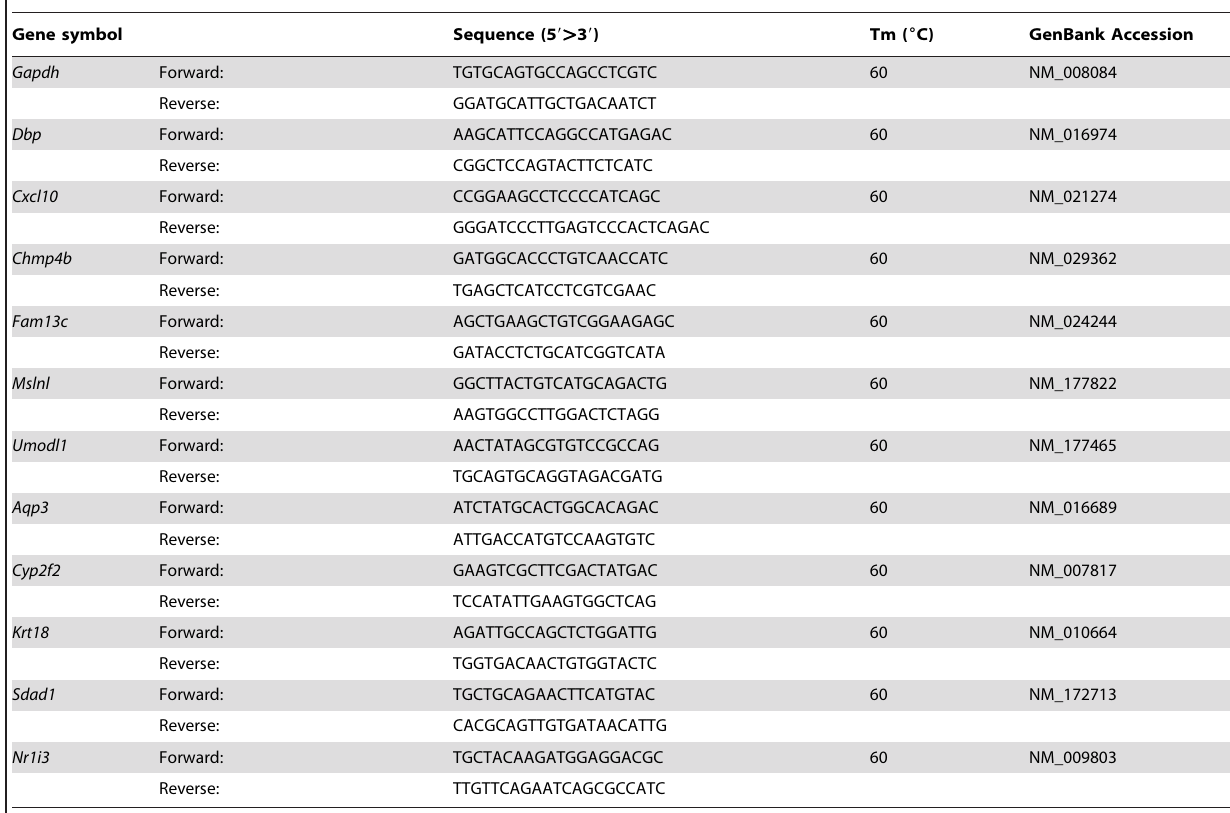
Table 1. Design of primer pairs for Real-Time RT-PCR analysis.